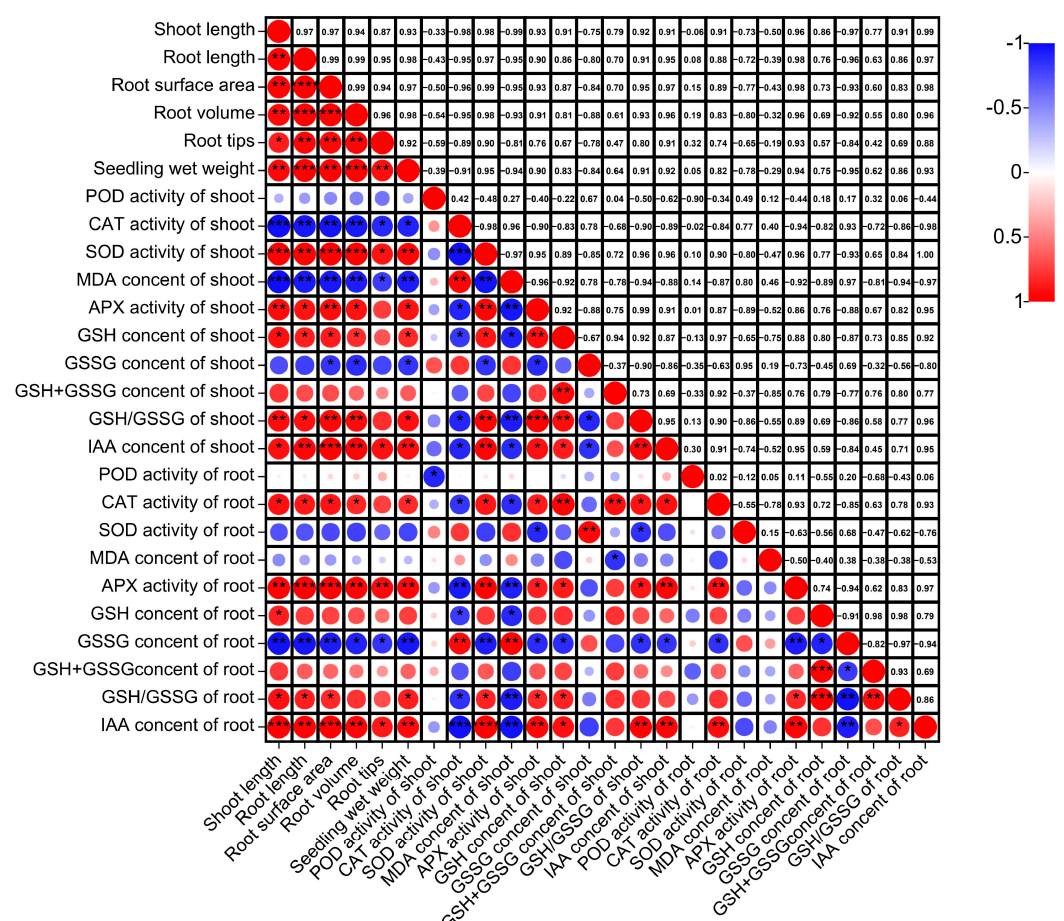
Figure 4. Correlation analysis of shoot growth and physiological indicators under submergence stress. ****: significant at the 0.0001 probability level ( p < 0.0001); ***: significant at the 0.001 probability level ( p < 0.001); **: significant at the 0.01 probability level ( p < 0.01); *: significant at the 0.05 probability level ( p < 0.05).